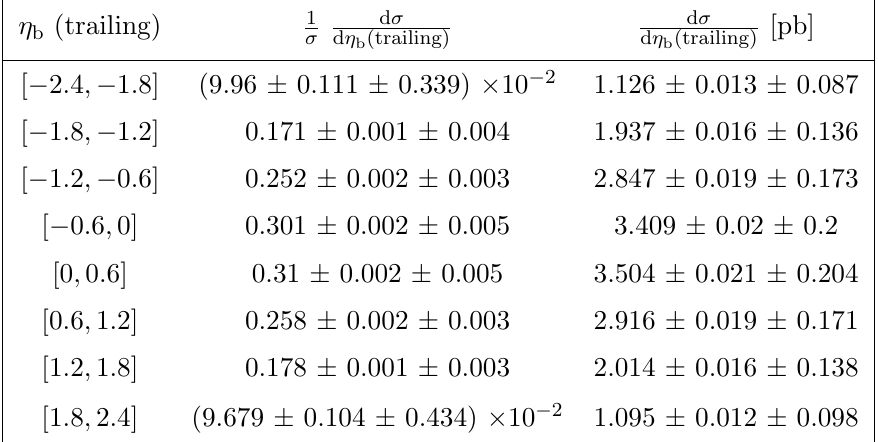
Table 44 . The measured di(cid:11)erential cross section and bin boundaries for each bin of the normalized and absolute measurements of the tt di(cid:11)erential cross section at particle level in the (cid:12)ducial phase space as a function of (cid:17) b (trailing) are tabulated.